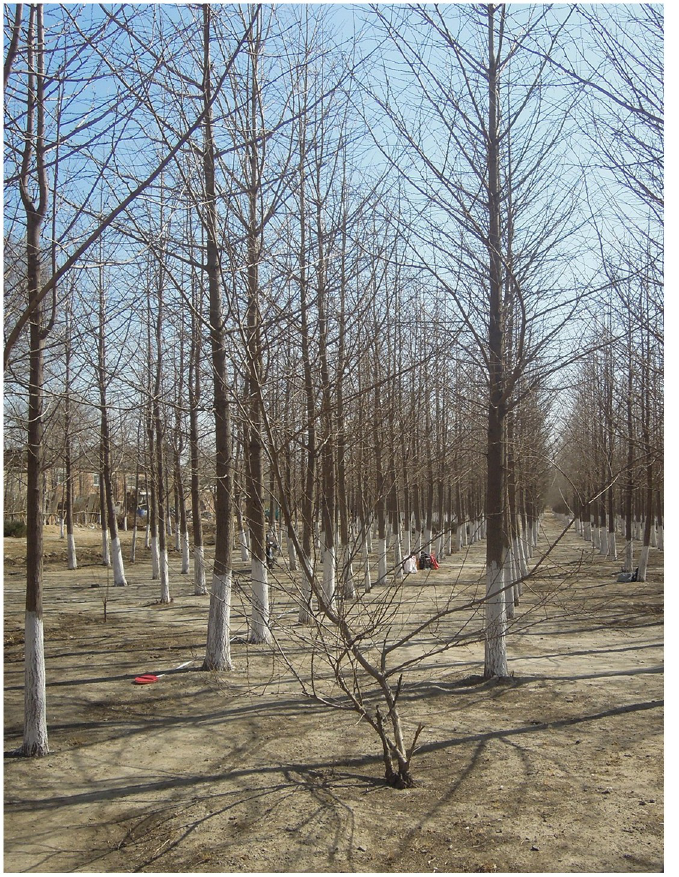
Fig 3. A picture of the field site.